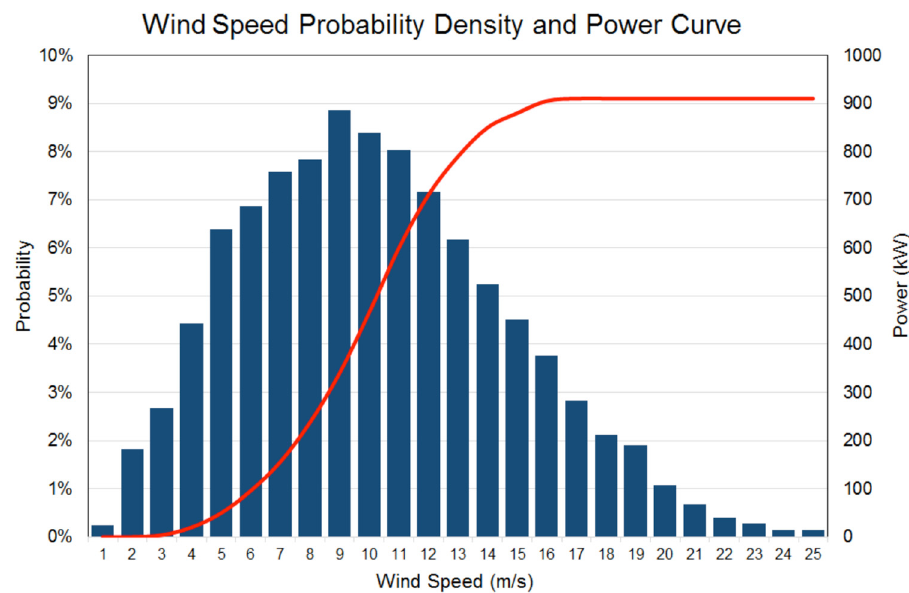
Fig. 1. Wind speed probability density for Amorgos island vs. E-44 WT power curve.